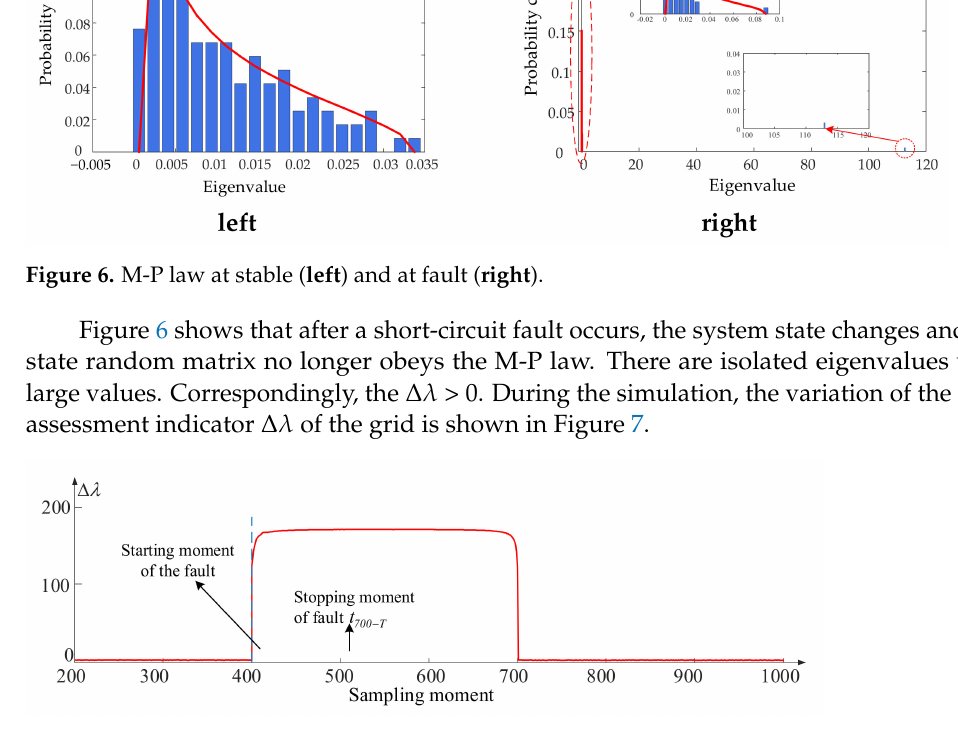
Figure 7. Change curve of ∆ λ .